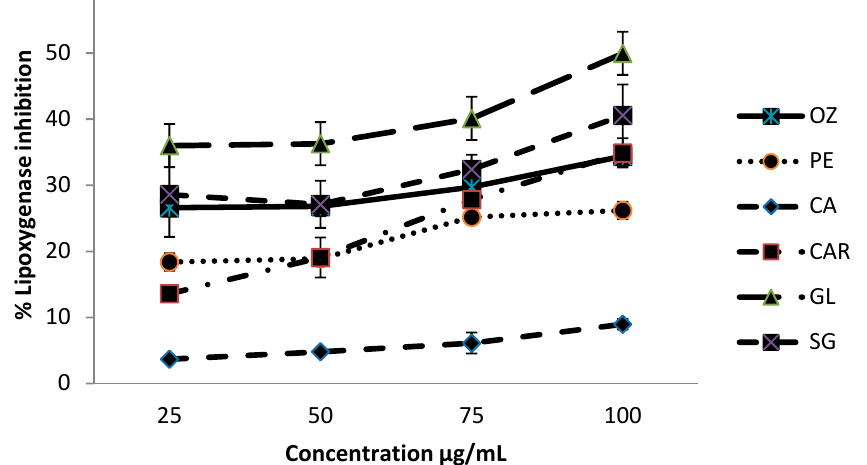
Figure 4. Lipoxygenase inhibitory activity of green leafy vegetables. Values represent means of triplicate readings. CAR— C. auriculata ; GL— G. lactiferum ; OZ— O. zeylanica ; PE— P. edulis ; CA— C. asiatica ; SG— S. grandiflora . Data are presented as the means ± standard deviations of three replicate determinations.